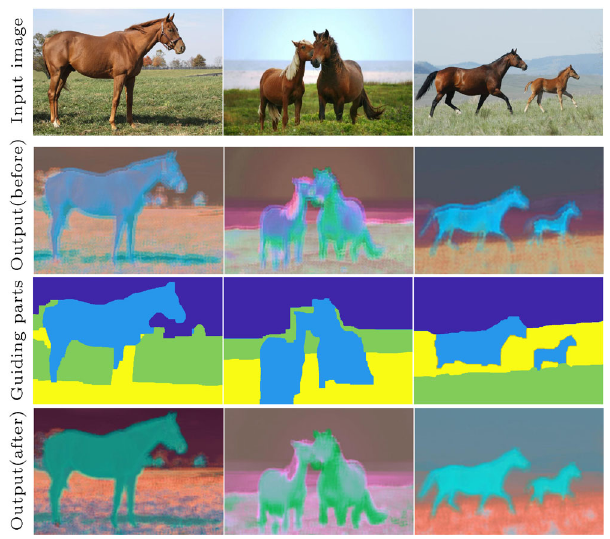
Refining the embedding using self-supervision. Given a new domain that contains a common foreground object (the input images on the top), we refine our initial embedding (second row) by automatically generating semantic guiding segments (in unique colors, third row) for the training images. This yields a more coherent embedding of the common object (bottom row).